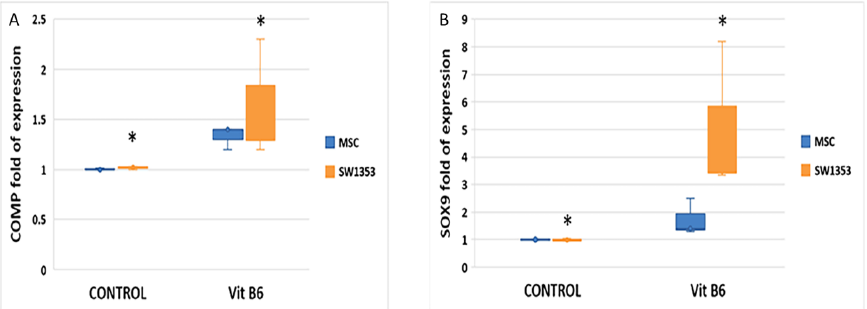
Figure 5. Vitamin B6 (100 µM) increased the expression levels of the chondrogenic transcription factor SOX9 ( A ) and of COMP ( B ) in both MSC and SW1353 cell lines; * p ≤ 0.05 vs.